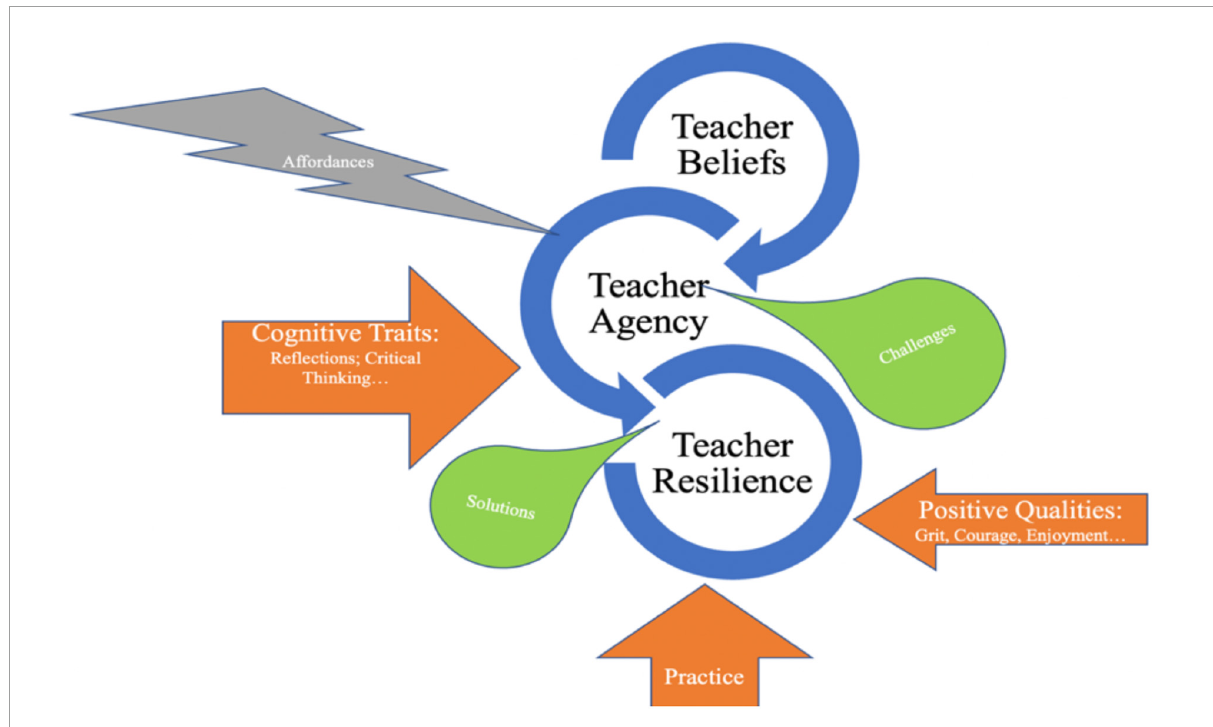
FIGURE1 An SCT framework in studying teacher beliefs, agency, and